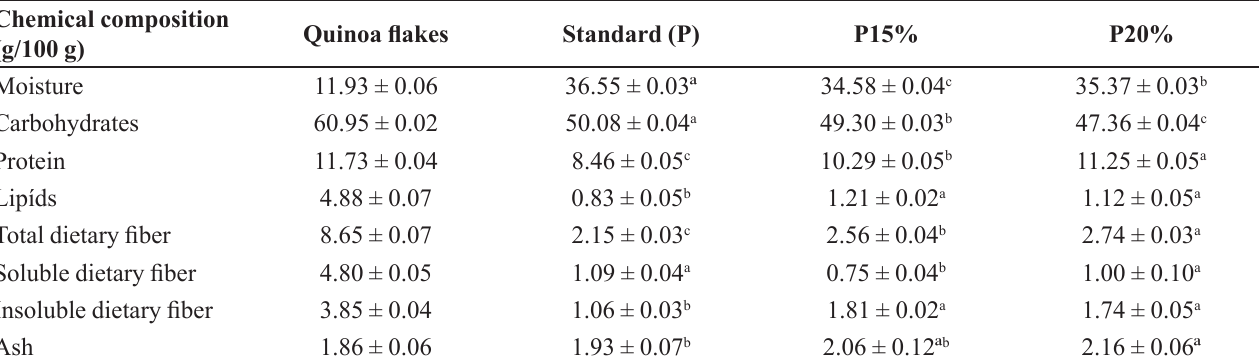
TABLE II - Chemical composition of quinoa flakes and bread made with and without pseudocereal Chemical composition